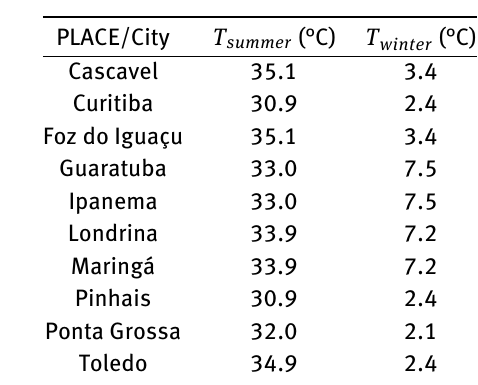
Table 1: Maximum external temperature of summer and minimum